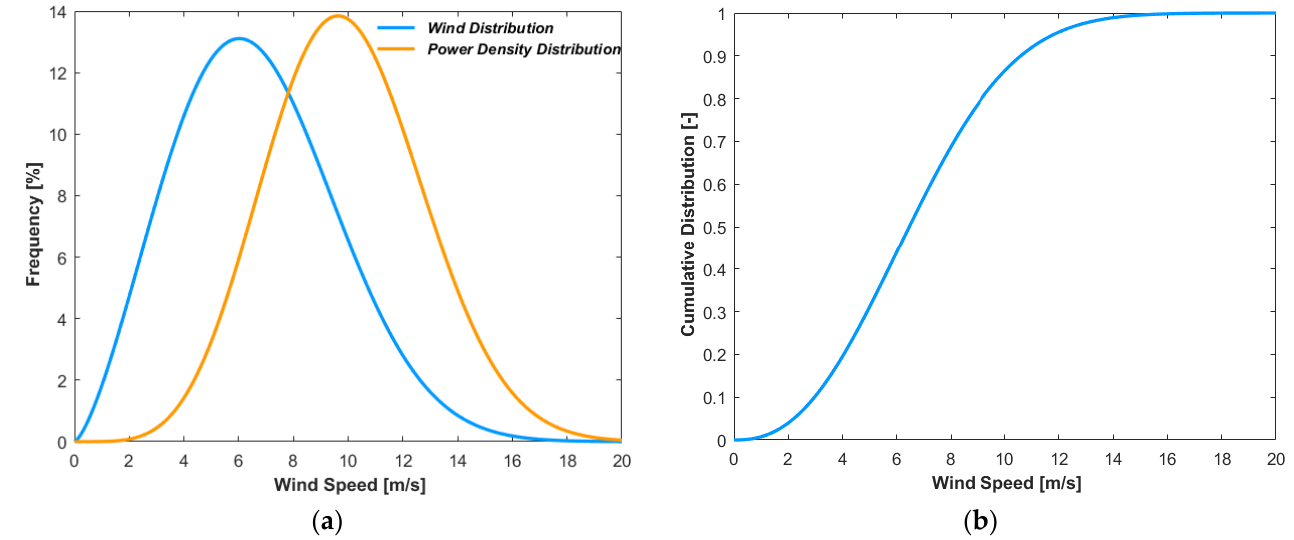
Figure 2. Weighted average wind characteristics of four sites around Mekelle based on the Weibull probability distribution with k = 2.42, c = 7.51, and standard deviation SD = 2.95. ( a ) Frequency distribution. ( b ) Cumulative distribution.